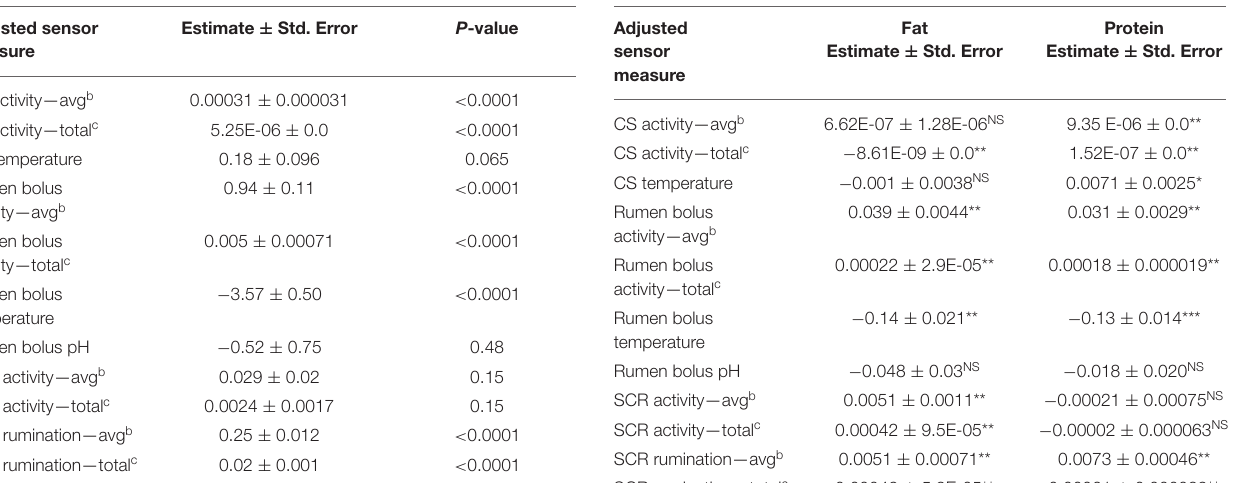
TABLE 2 | The association of sensor measures a with milk yield (kg). TABLE 3 | The association of sensor measures a with milk composition traits (kg).